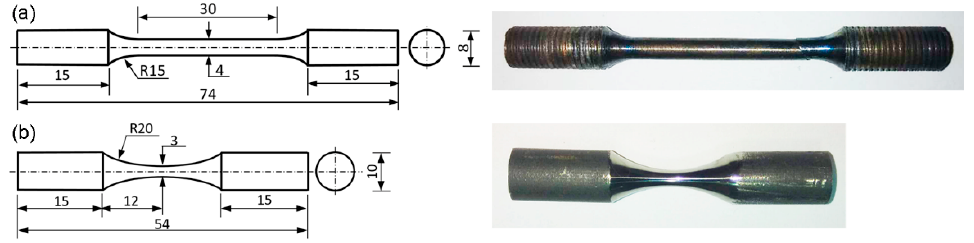
Figure 1. Geometric characteristics of ( a ) tensile and ( b ) ultrasonic fatigue samples (all dimensions in mm).